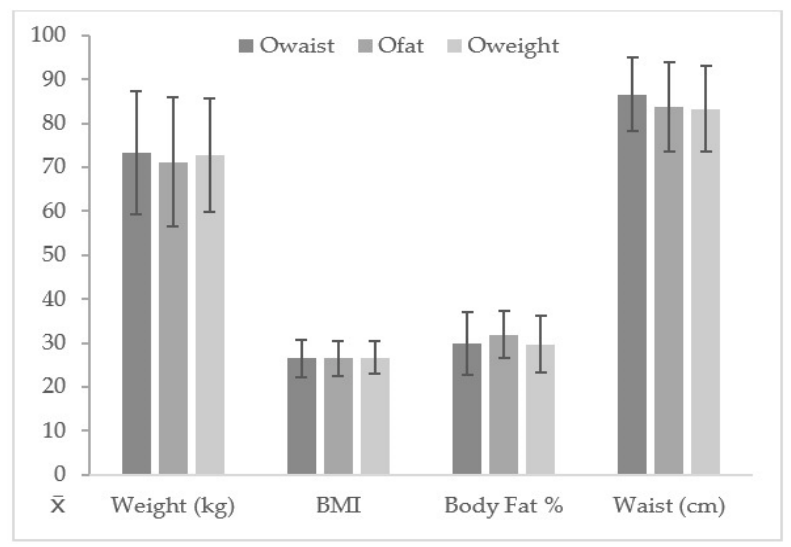
Figure 2. Body composition parameters according to O waist , O fat , and O weight groups.